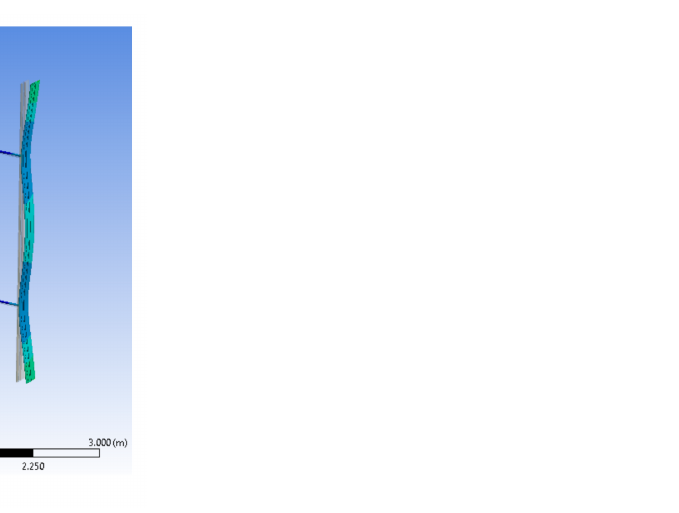
Figure 11. Graphical representation of the deformation of the turbine blades with ( a ) KR0, ( b ) KR1,